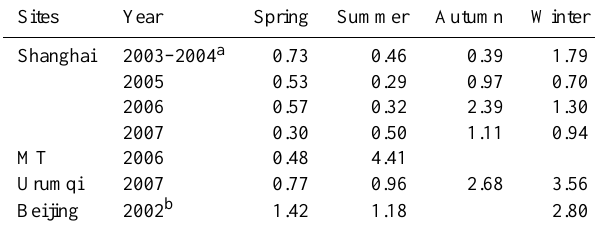
Fig. 8. Daily contributions of biomass burning, crustal dust, and others in PM 2.5 at MT.